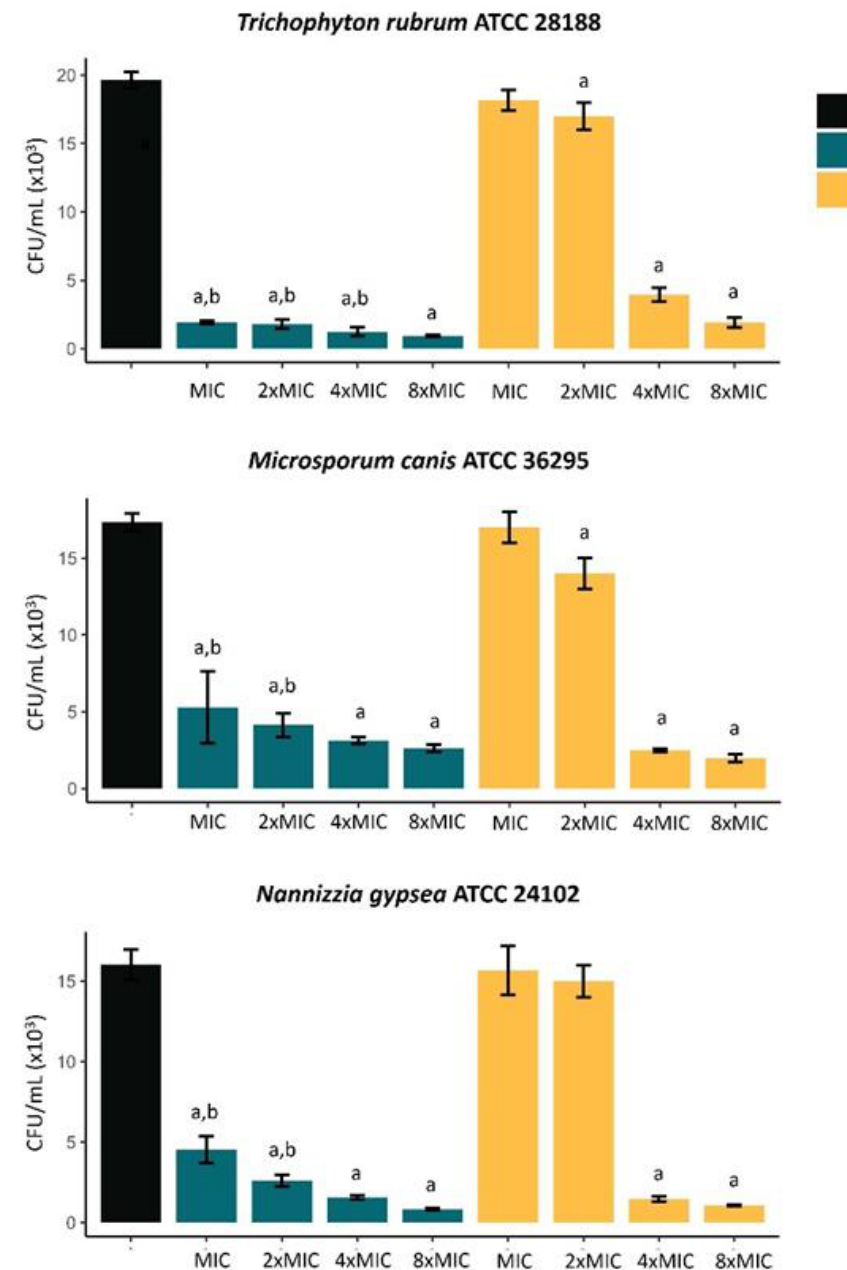
Figure 3. Effect of RIP3 on the viability of in vitro biofilms of dermatophytes determined by quantifying the number of colony-forming units (CFU). The results are the means ± SD from three independent experiments. Significant difference ( p < 0.05) when compared to drug-free growth control (a) and to CPX at the respective MIC value (b). OD, optical density; MIC, minimal inhibitory concentration; RIP3, riparin III; CPX, ciclopirox.